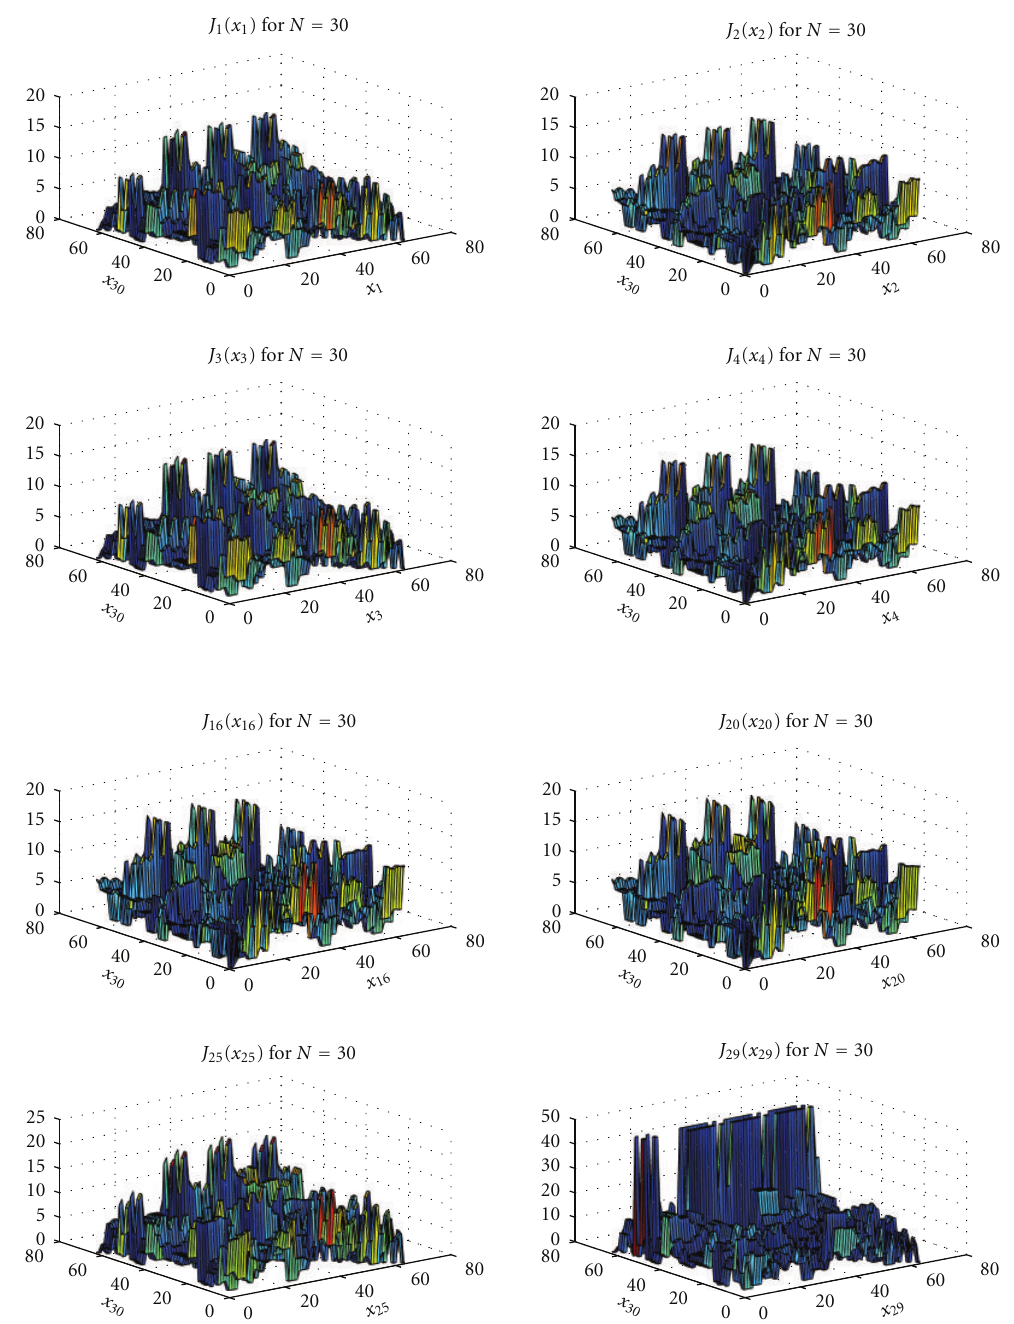
= χ , probability 1